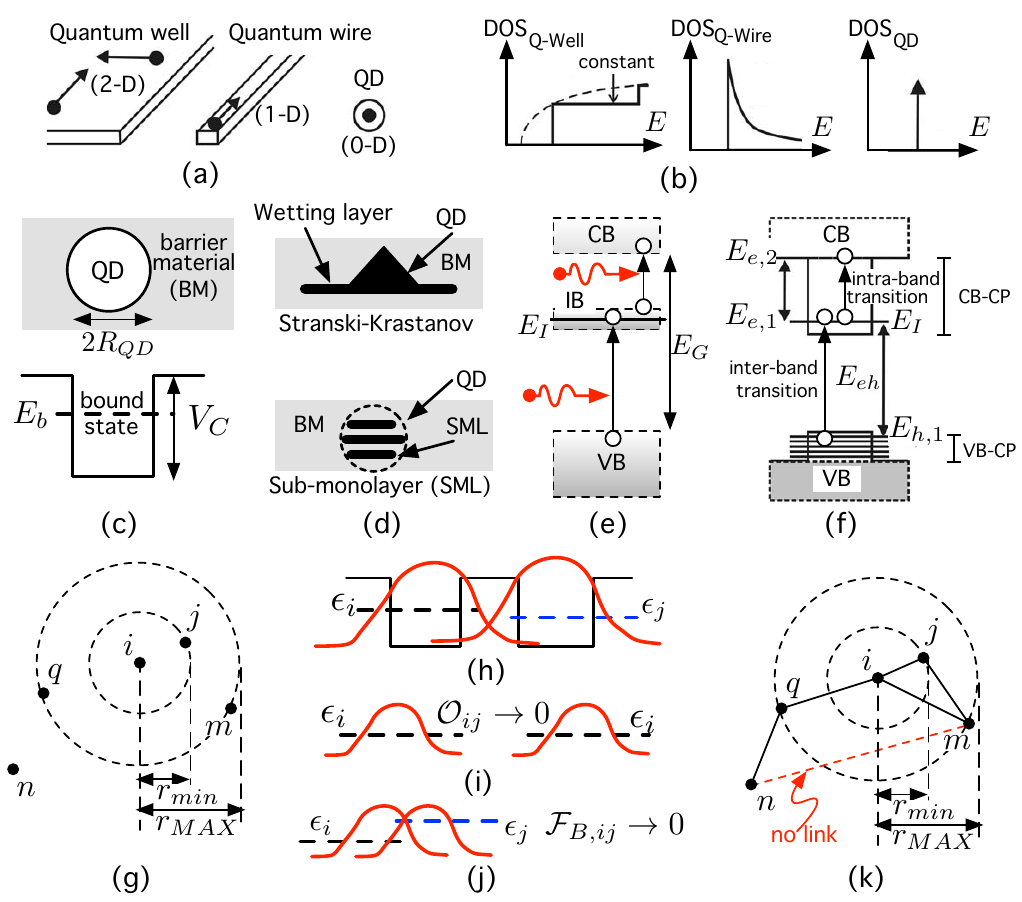
Figure 1. ( a ) Illustration of low-dimensional nanostructures. ( b ) Corresponding density of states (DOS). ( c ) Simplified quantum dot (QD). ( d ) Different classes of growth in self-assembled QDs. ( e ) Three electron gases in an intermediate-band solar cell. ( f ) QD and energy levels. ( g ) Distribution of QDs ( = nodes). ( h ) Allowed electron hopping situation. ( i , j ) Forbidden electron hopping cases. ( k ) Link generation in the spacial node distribution in ( g ) according to the processes illustrated in ( h , i ). See the main text for further